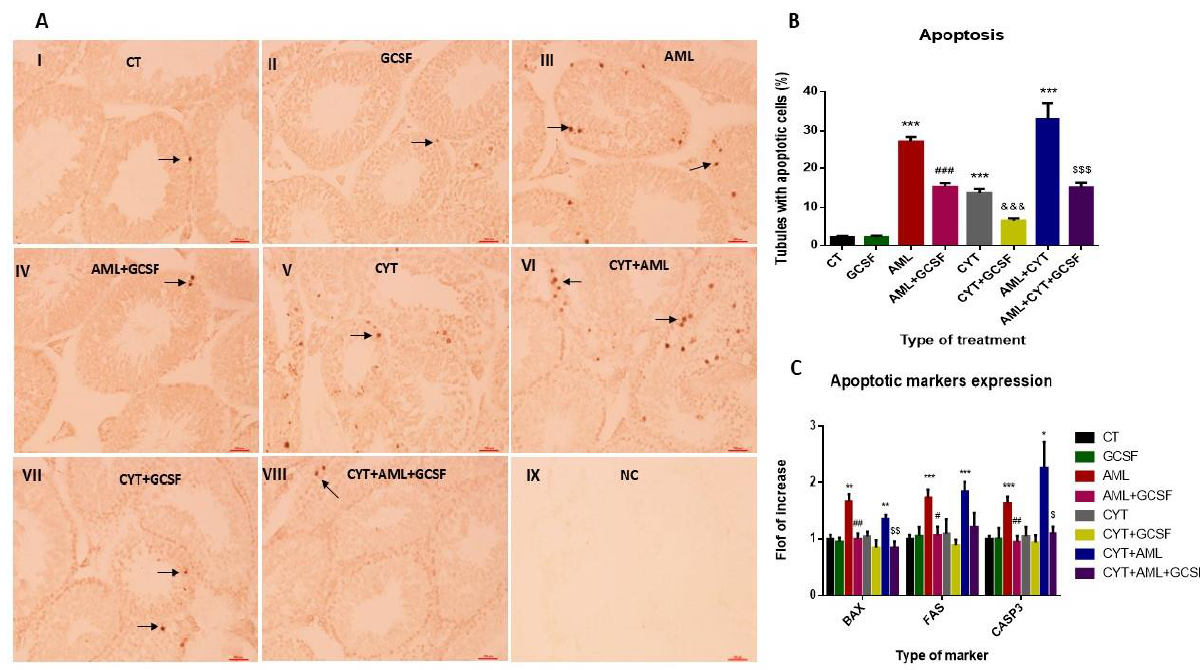
Figure 4. Effect of GCSF on apoptosis of testicular cells in AML- and CYT-treated groups. Mice were treated as described in Figure 2. Testes from mice after 3 weeks of treatment were examined for apoptosis. TUNEL assay ( A ) was performed as described in Materials and Methods for testicular tissue from all the examined groups (control, CT, I; GCSF, II; AML, III; AML + GCSF, IV; CYT, V; CYT + AML, VI; CYT + GCSF, VII; CYT + AML + GCSF, VIII; negative control, NC, IX). The percentage of tubules with more than 5 apoptotic cells has been calculated ( B ). The RNA expression levels of the apoptotic markers (BAX, FAS, Casp3) in testes of all examined groups were tested by qPCR analysis using specific primers ( C ). qPCR results of each apoptotic marker are presented as fold of increase compared to the control group (CT). The results are representative of 3 independent experiments with 3 mice in each group per experiment. *—significant compared to